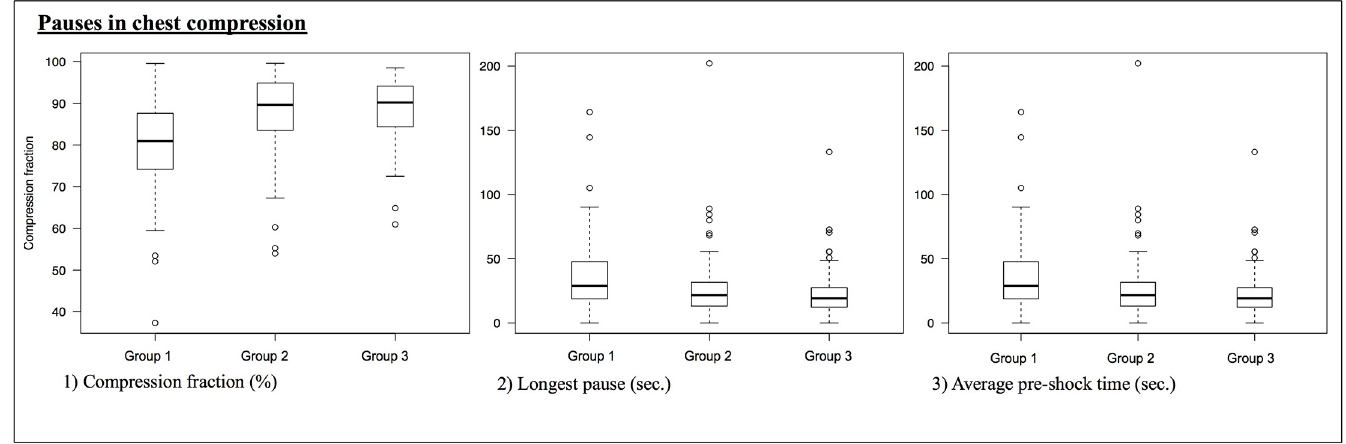
Fig 3. Pauses in chest